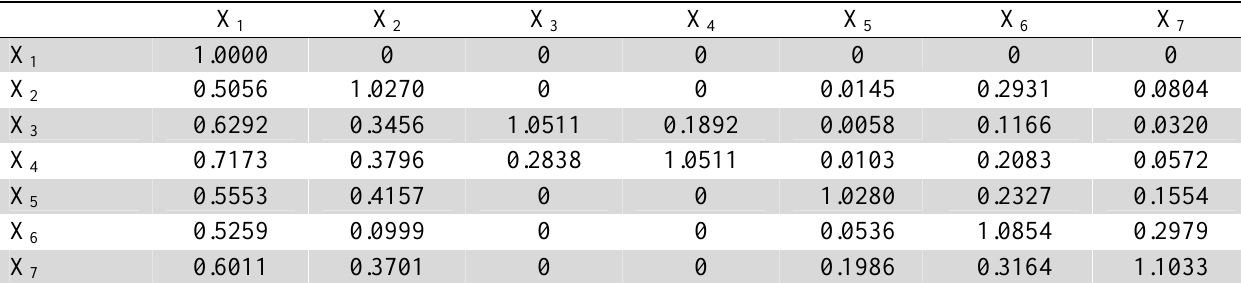
The summary of direct effects